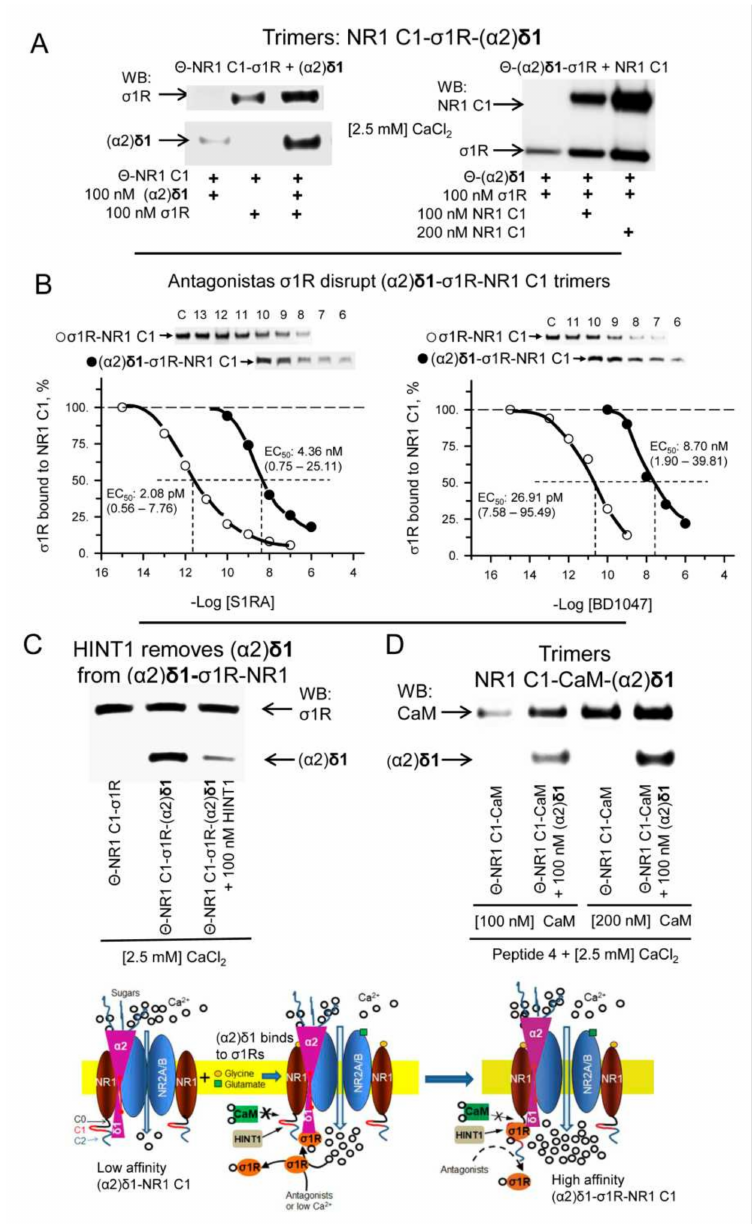
Figure 9. Trimeric associations of ( α 2) δ 1 peptides with σ 1R/CaM and NR1 C1 subunits. ( A ) For- mation of ( α 2) δ 1- σ 1R-NR1 C1 trimers. Agarose( Θ )-attached NR1 C1- σ 1R dimers were incubated